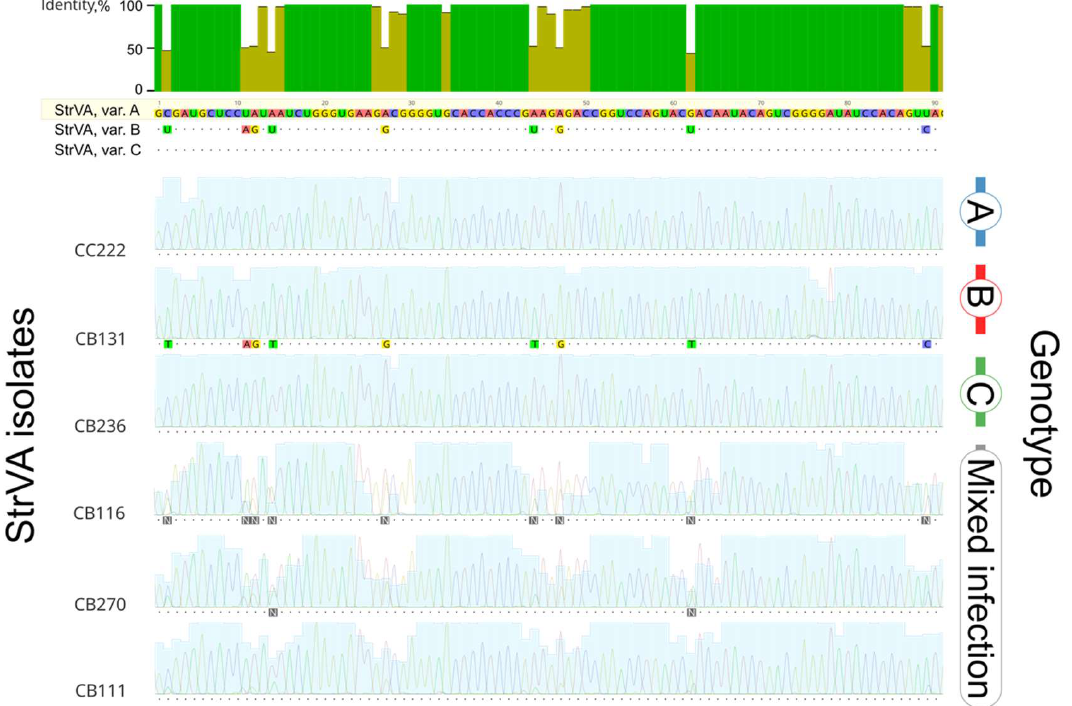
Figure 7. Multiple sequence alignment of the replicase gene region (genome positions 610–699) of several StrVA isolates (all 48 isolates are shown in Figure S1). StrVA variant A was chosen as the reference. For other sequences, matching bases are shown as dots, and differences are highlighted. Multiple peaks indicate the presence of more than one StrVA genotype.